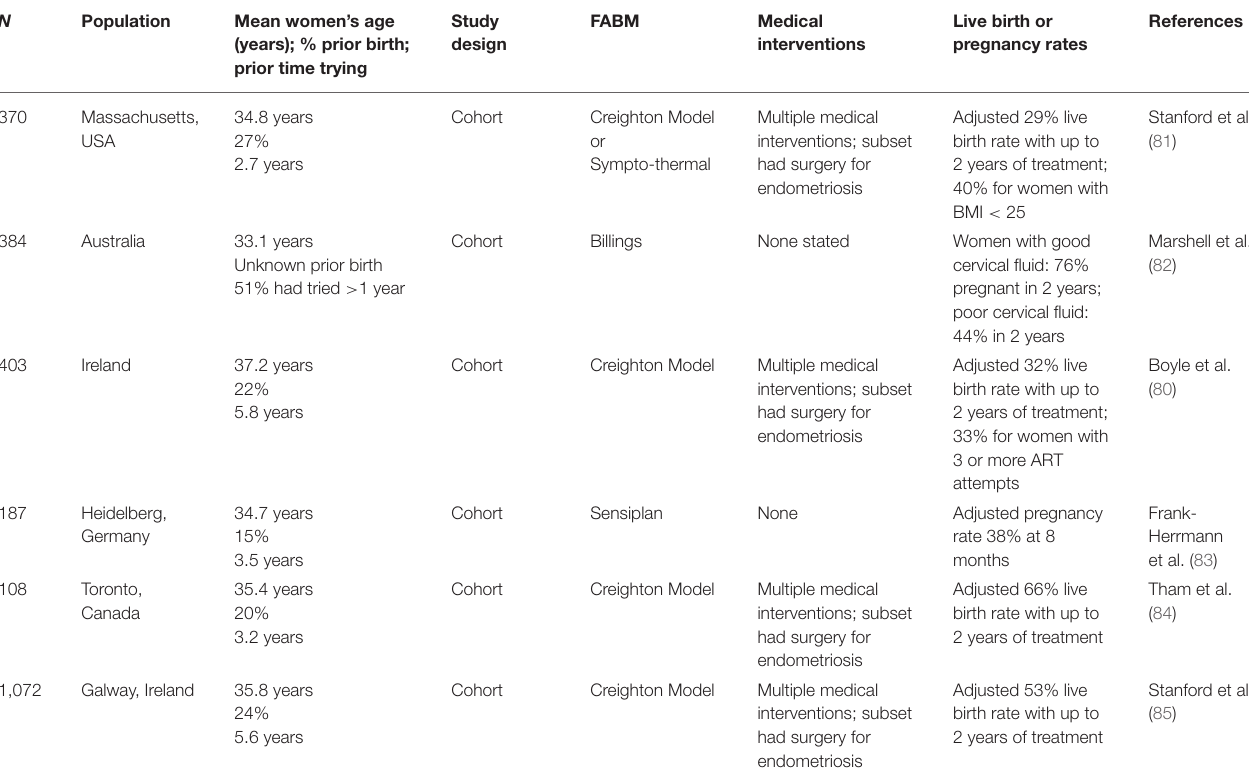
TABLE 5 | Effectiveness of fertility awareness-based methods in women or couples with subfertility trying to conceive.